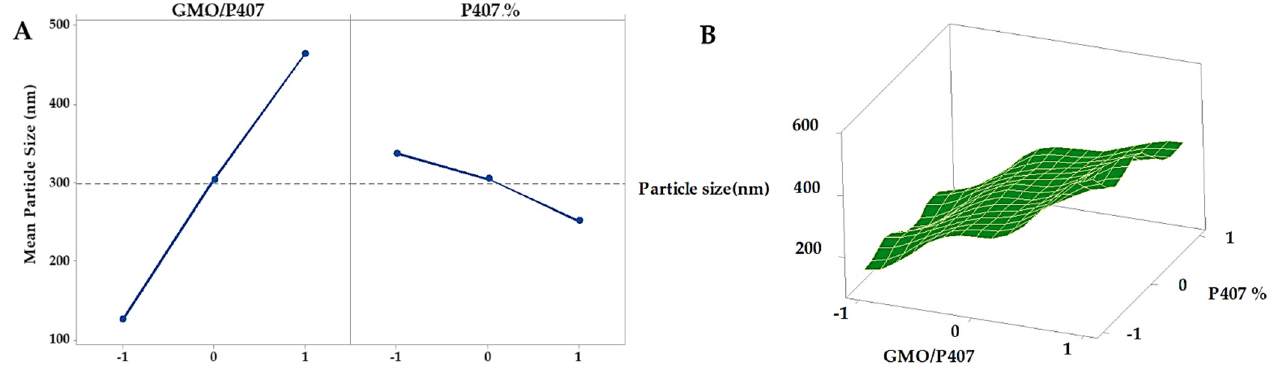
Figure 7. Main effects ( A ) and response surface plots ( B ) of GMO/P407 and P407% on particle size.